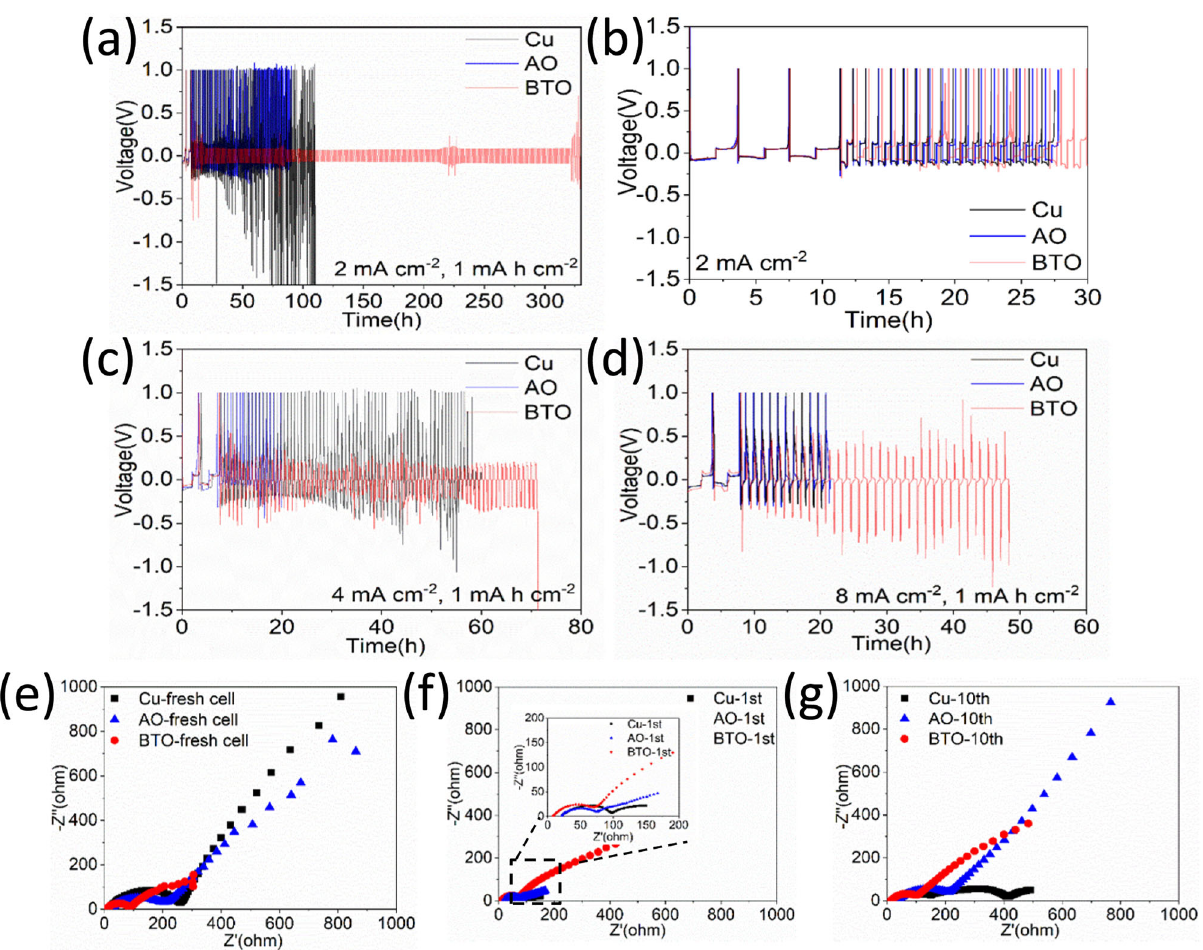
Fig. 4 Half-cell voltage evolution of the anode-free Cu and AO and BTO scaffolds vs a Li metal electrode. Evolution of the voltage during Li plating/ stripping a with a fi xed areal capacity of 1 mA h cm − 2 and b with a voltage limit at 1.0 V vs Li/Li + at 2 mA cm − 2 using three different electrodes. Evolution of the voltage of cells performed at the current density of c 4 mA cm − 2 and d 8 mA cm − 2 with the anode-free half-cell cycling protocol (1). Electrochemical impedance spectra of the half-cells for the bare Cu and the AO and BTO scaffolds e fresh cells, f the 1 st cycle and g the 10 th cycle measured at a current density of 2 mA cm − 2